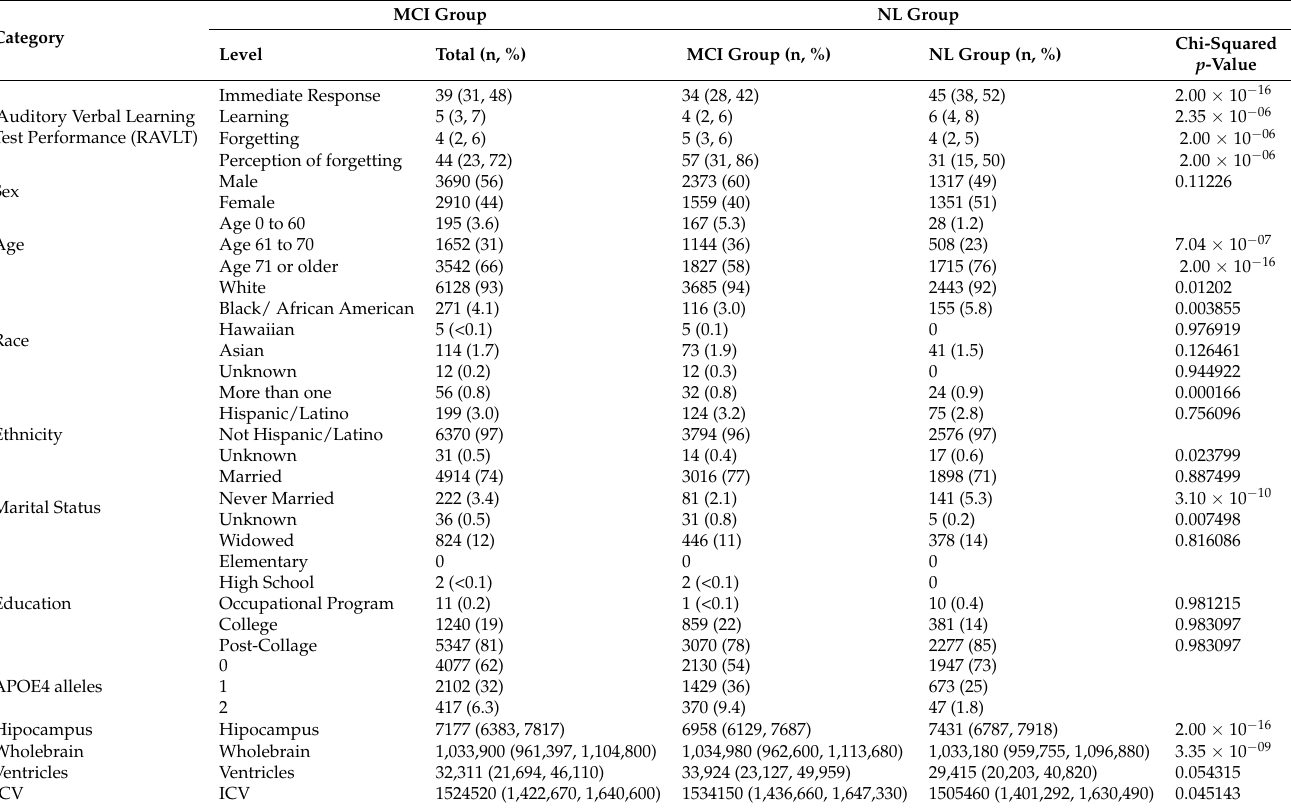
Table 1. Demographic characteristics of the study population per RAVLT test